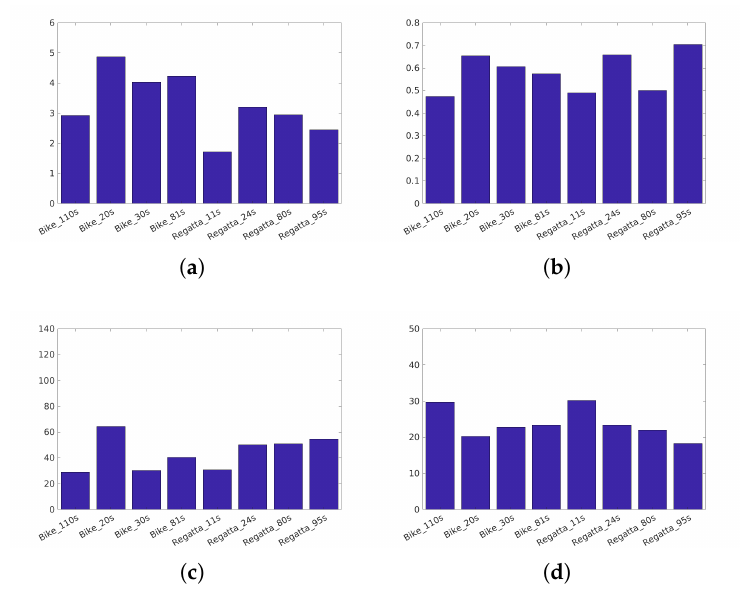
Figure 7. Characteristics of the 4Kdtb images: (( a ) The dynamic range, ( b ) key, ( c ) spatial Information, ( d )